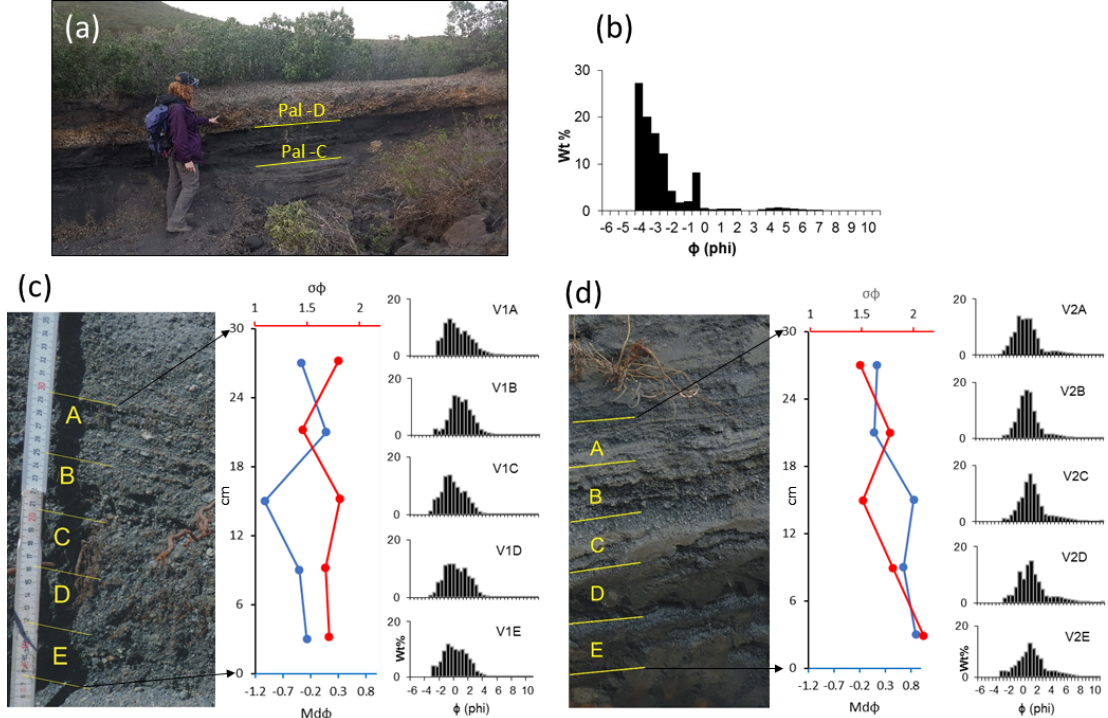
Figure 3. (a) PAL-D subplinian tephra fallout deposit outcrop (V3; Fig.1). (b) Grain size distribution of PAL-D subplinian tephra fallout deposit. (c, d) Md (cid:56) , σ(cid:56) , and grain size distribution of the first 30cm of the tephra fallout deposit associated with the 1888–1890 Vulcanian eruption for stratigraphic sections V1 and V2 (Fig. 1). Thickness of the layers analysed: A (24–30cm); B (24–18cm); C (18–12cm); D (12–6cm); E